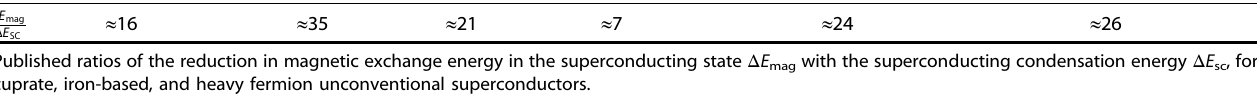
Table 1. The relationship between magnetic exchange and superconducting condensation energies in unconventional superconductors. 16 – 21 . YBa 2 Cu 3 O